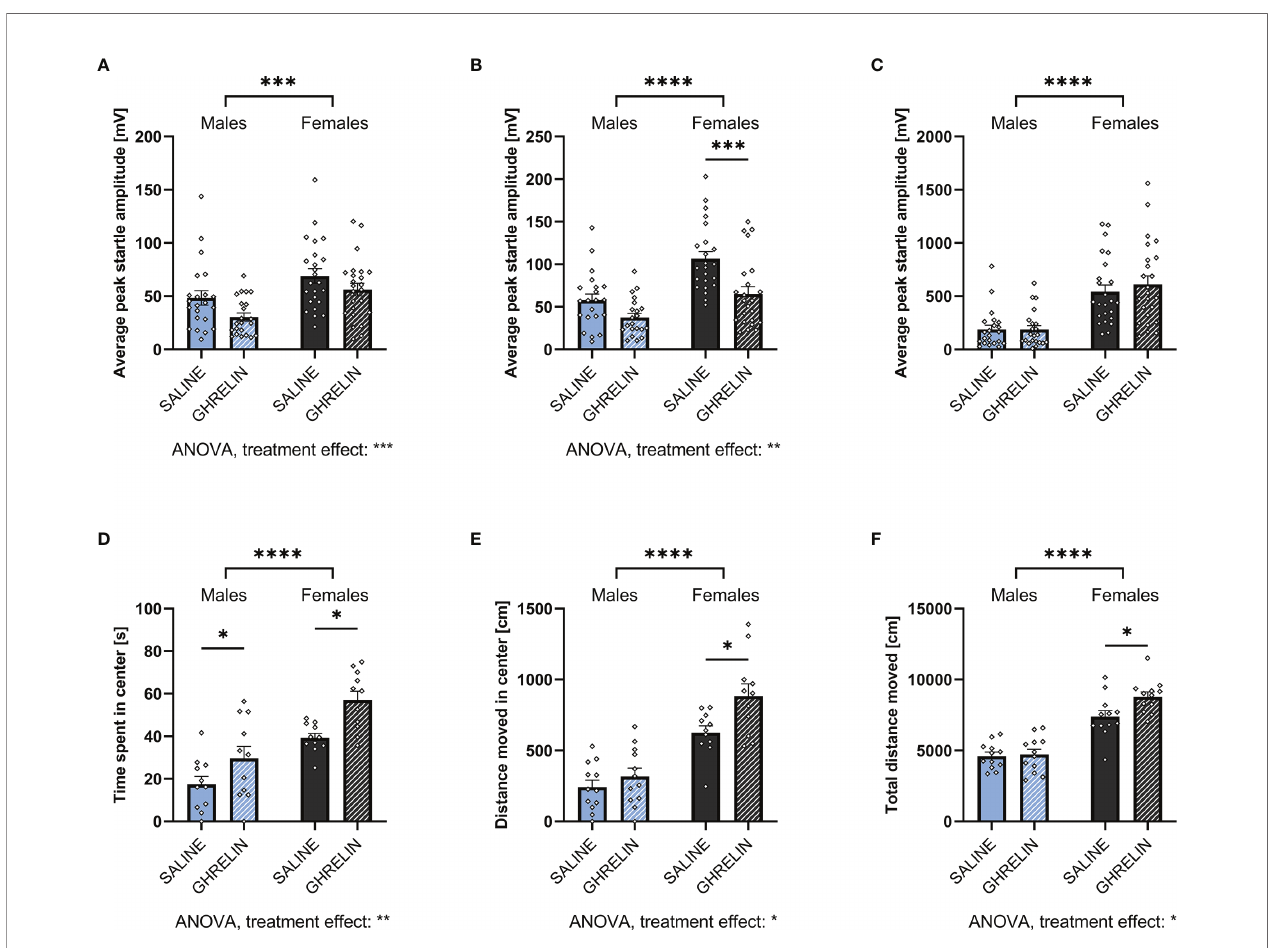
FIGURE 5 | Ghrelin administration is anxiolytic in the ASR and OF. Treating ad libitum fed male and female rats with ghrelin did not affect the ASR following a 90dB white noise burst (A) . At 95dB, only ghrelin-treated females displayed a decreased startle amplitude (B) , however, at 105dB no signi fi cant difference was detected in both sexes (C) . In the OF, ghrelin treatment increased the time in the center (D) . Only females also increased the distance moved in the center (E) as well as the total locomotion in the OF when treated with ghrelin (F) . All data are presented as mean ± SEM. * p < 0.05, *** p < 0.001, **** p < 0.0001 compared with respective controls. n = 21 (males) and n = 23 (females) per treatment group in each sex in the ASR and n = 12 in the OF per treatment group respectively. ASR, acoustic startle response; OF, open fi